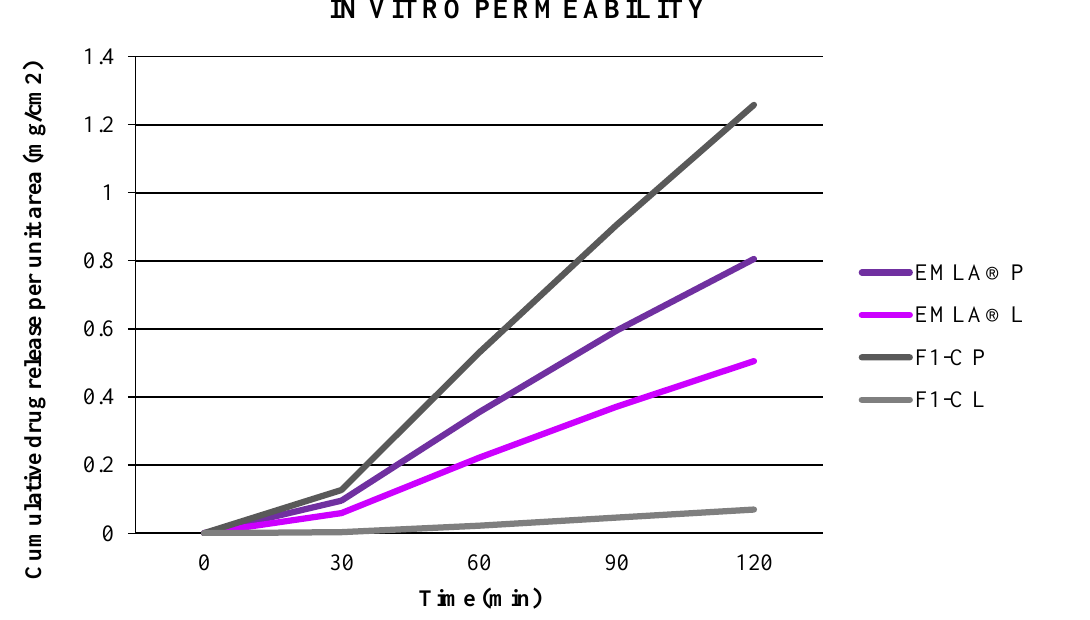
Figure 4. In vitro permeability of prilocaine and lidocaine of NIO-HAMIN F1-C emulgel after reformulated using a cold process method VS EMLA ® cream. (P: prilocaine; L: lidocaine).